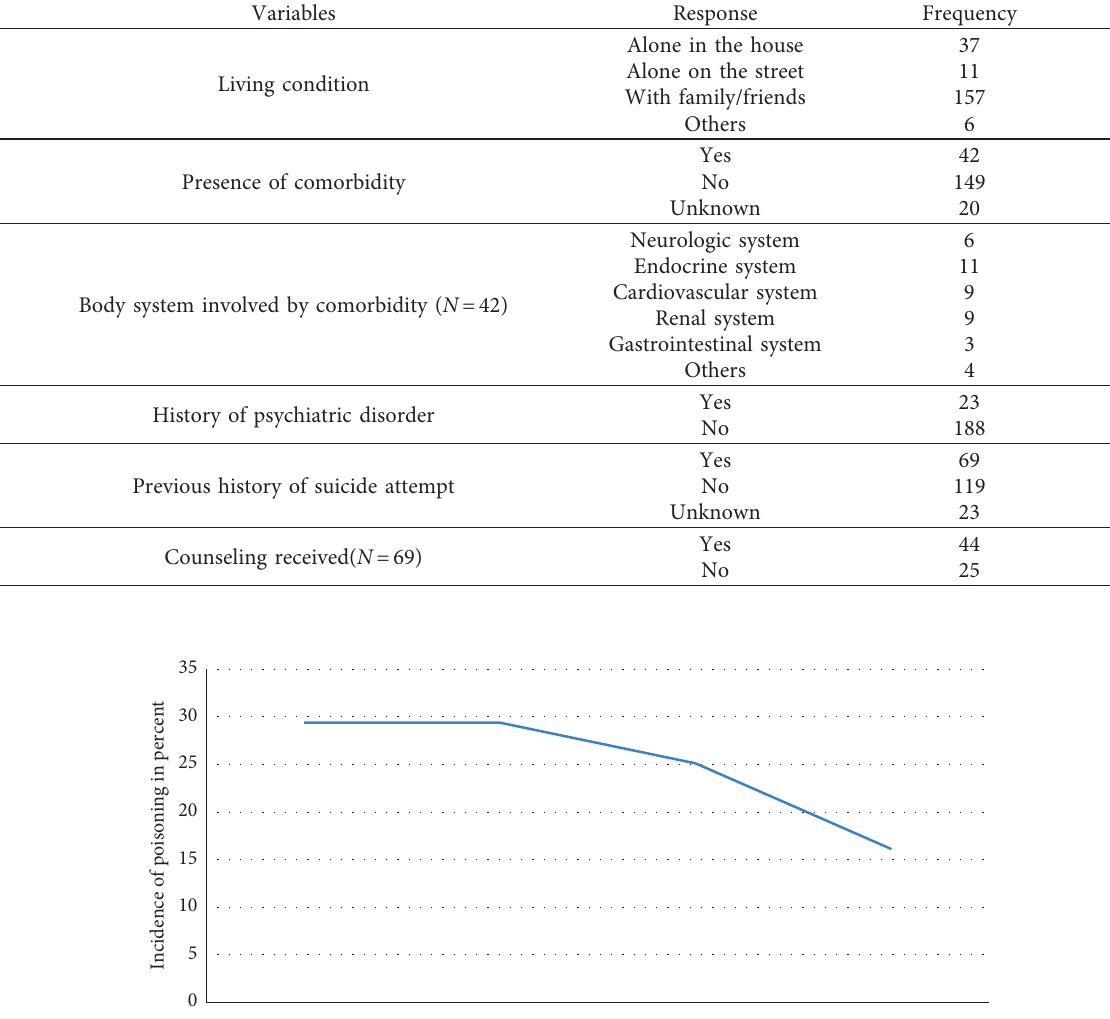
Table 2: Base line information of the study participants in western Ethiopia, 2018.